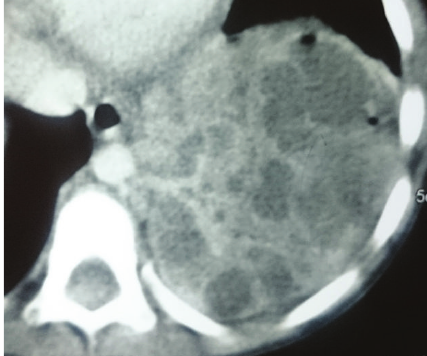
Figure 2: Computed tomography (CT) of chest revealed a multiloc- ulated mass in the left lower lobe of the lung.